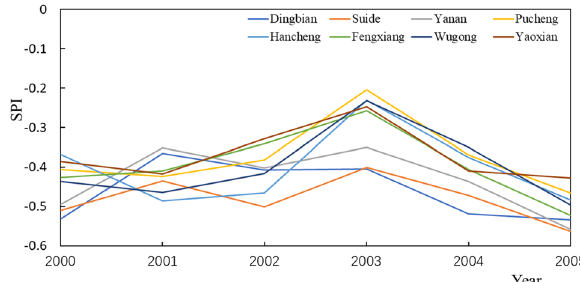
Figure 6. SPI changes at each site from 2000 to 2005.